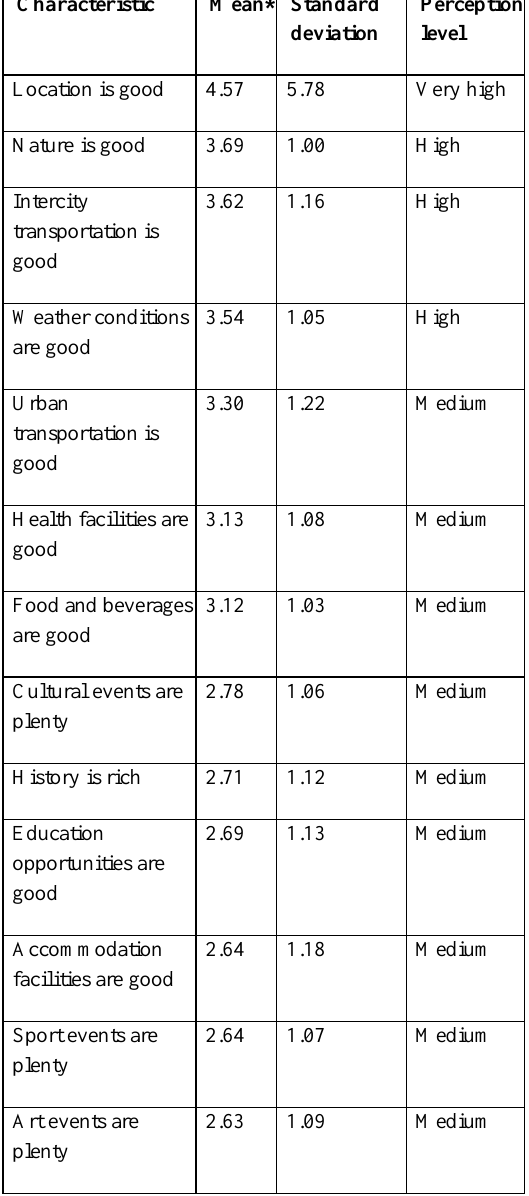
Table 3. Image Perceptions on Opportunities (Advantages) of Yalova City Characteristic Mean* Standard deviation